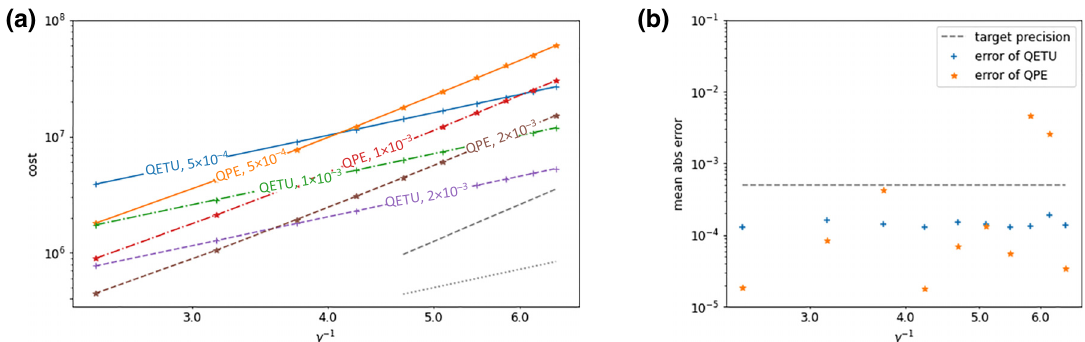
FIG. 4. A comparison of the performance of the algorithm in Theorem 4 and the single-ancilla qubit quantum phase estimation using a semiclassical Fourier transform [44,45,47]. (a) The number of queries of U needed to reach target precision (cid:4) = 5 × 10 − 4 , 10 − 3 , and 2 × 10 − 3 for different values of γ . The gray dashed line and dotted line show γ − 4 scaling and γ − 2 scaling, respectively. Both axes are in logarithmic scale. (b) The mean absolute error achieved by the two algorithms for target accuracy (cid:4) = 5 × 10 − 4